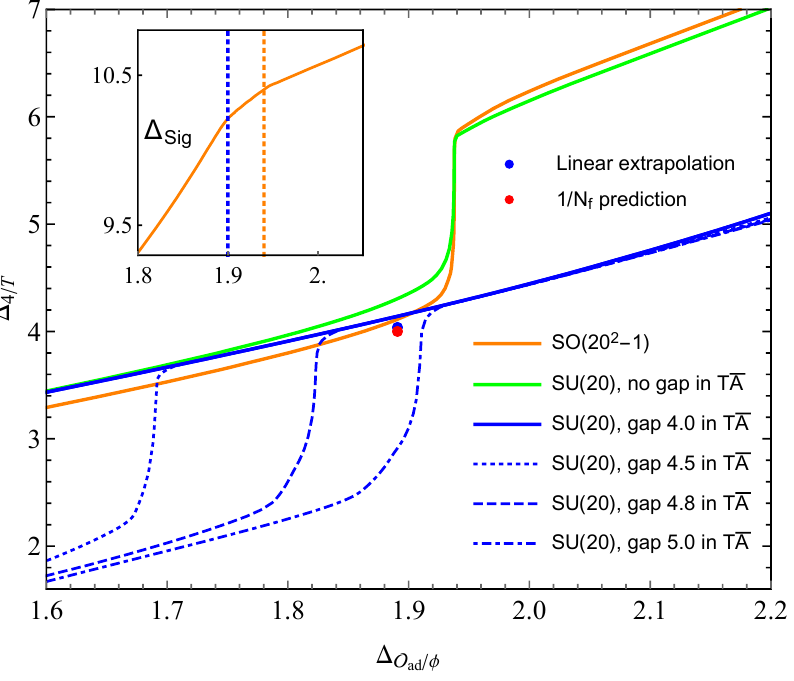
Figure 4 . Bounds on ∆ 4 and ∆ T from SU(20) adjoint and SO(399) vector bootstrap. In the left-top window, the orange line gives the singlet upper bound obtained from SO(399) vector bootstrap with two kinks near ∆ φ = 1 . 90 and 1 . 94